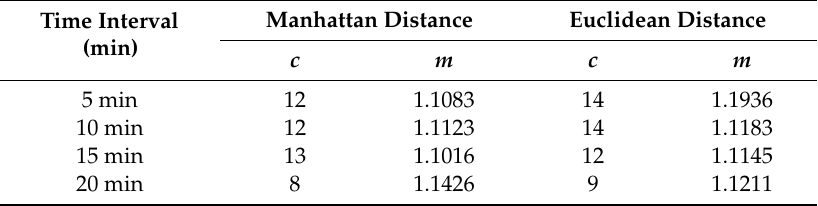
Table 3. Optimized parameters obtained by the integrated imputation